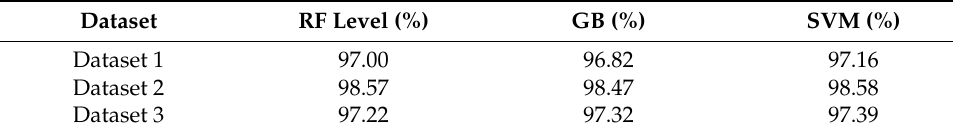
Table 12. The accuracy of the optimized stacking ensemble